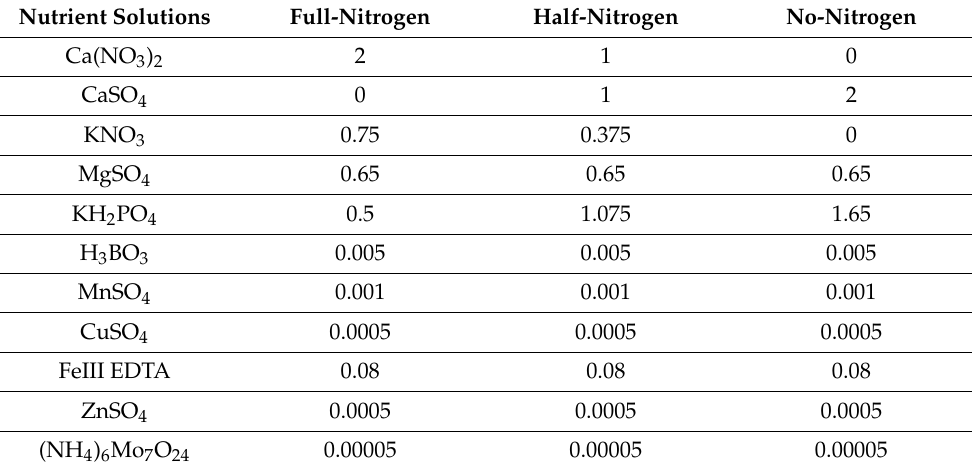
Table 1. Mineral composition of nutrient solutions. Concentrations are reported in